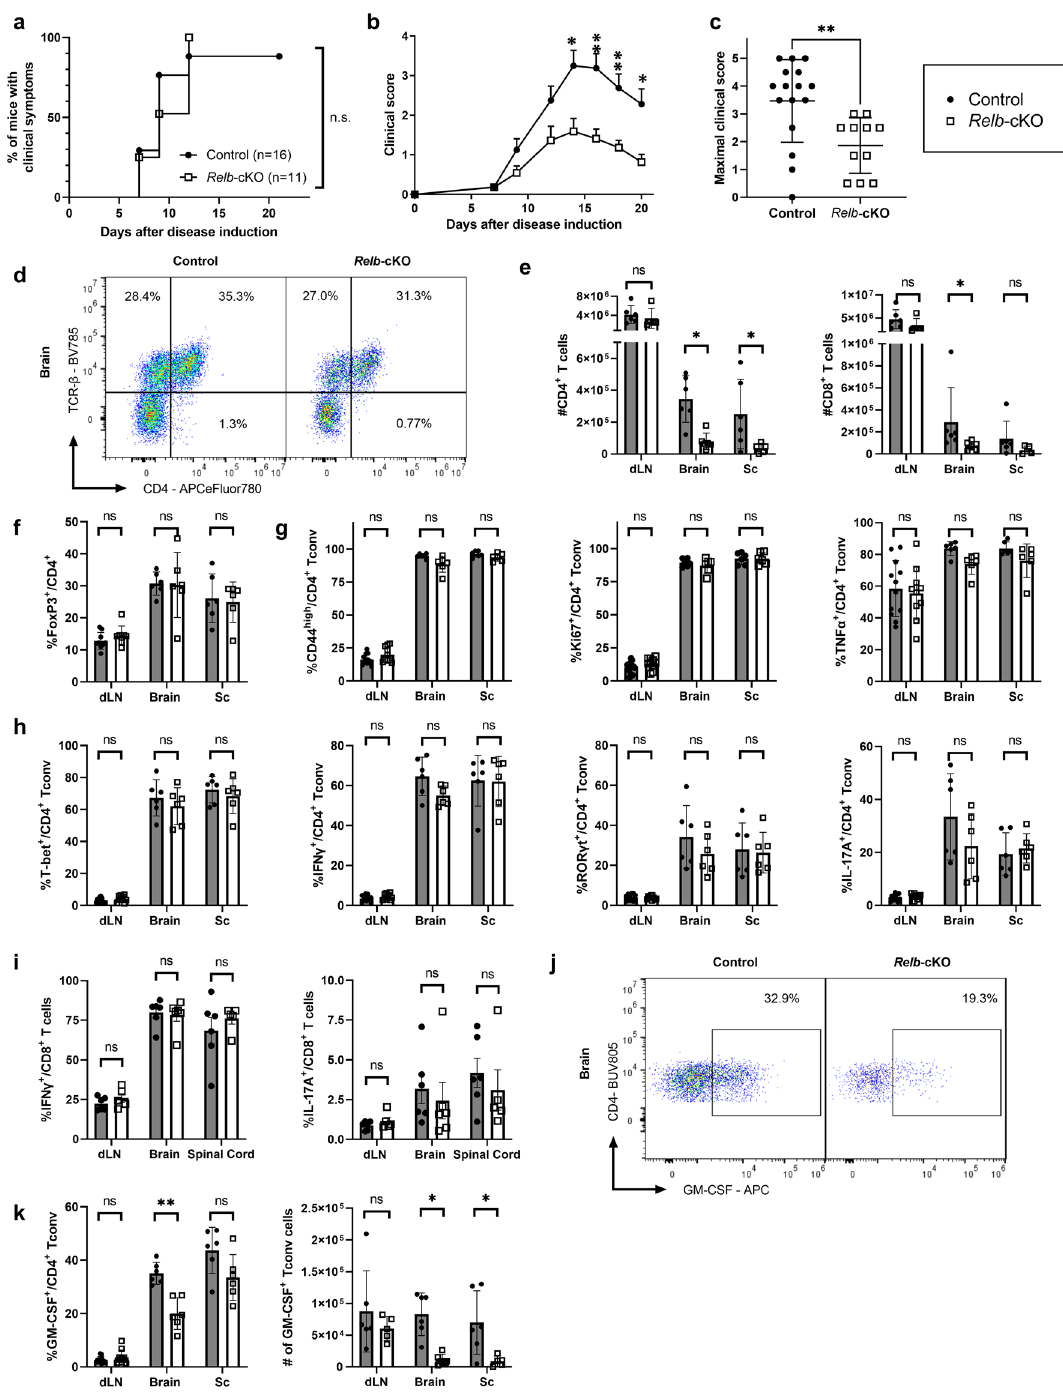
Figure 5. T-cell autonomous RelB is required for optimal pathogenicity in EAE. Active EAE was induced as described in the Methods . ( a ) Cumulative incidence of detectable disease (score > 0), ( b ) mean clinical scores and ( c ) maximal scores of each mouse during the course of disease were recorded. ( d-k ) 21 days after transfer, tissues were processed for FACS analyses following restimulation with PMA/ionomycin. ( d ) Representative TCRβ and CD45 staining in gated live brain cells. ( e ) Absolute numbers of CD4 + and CD8 + T cells (live CD45 + TCRβ + CD4 + / CD8 + ) in the indicated tissues. ( f ) Percentage of Treg cells among CD4 + T cells. ( g,h ) Percentage of Tconv cells (live CD45 + TCRβ + CD4 + Foxp3 - ) expressing the indicated markers. ( i ) Percentage of IFNγ and IL-17A expressing CD8 + T cells (live CD45 + TCRβ + CD8 + ) ( j ) Representative GM-CSF staining in brain Tconv cells. ( k ) Cumulative proportion and number of live CD45 + TCRβ + CD4 + Foxp3 - GM-CSF + Tconv cells. Each dot represents a mouse from 3 independent experiments; mean + /- SEM is shown. *p < 0.05, **p < 0.005, ns: